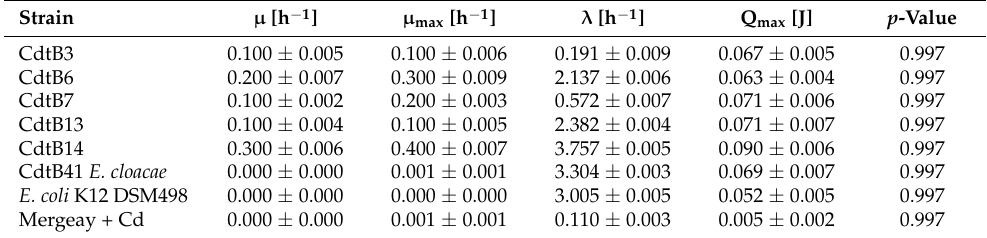
Table 2. Kinetical growth and thermodynamical parameters of cadmium-tolerant bacteria (CdtB) Cd immobilization activity. The parameters were calculated by fitting the Richards equation [30,31,35] to the heat flow data obtained by IMC. The p -value corresponds to the statistical significance of fitting the Richards equation into the heat flow data (for all parameters, n =